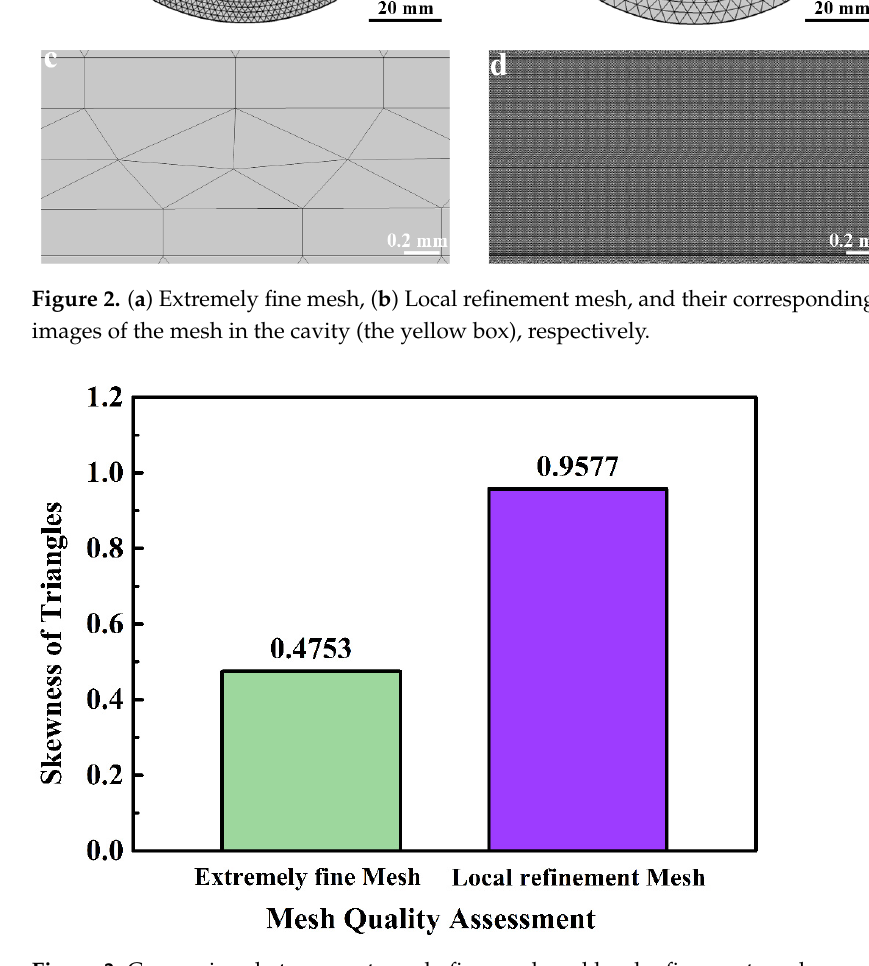
Figure 3. Comparison between extremely fine mesh and local refinement mesh. Table 2. Parameters used in the multiphysics model.